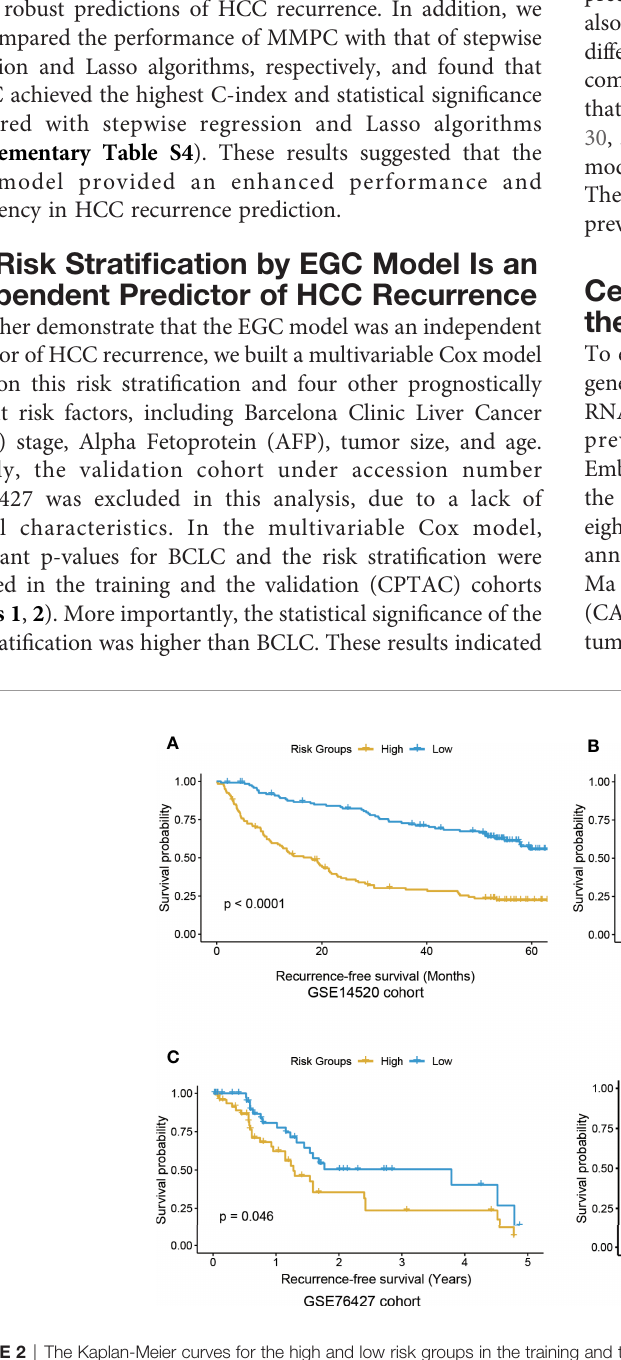
FIGURE 2 | The Kaplan-Meier curves for the high and low risk groups in the training and three validation cohorts. The KM curves of training and three validation cohorts were displayed in (A – D) , respectively. The yellow and blue curves represent the high and low risk groups,